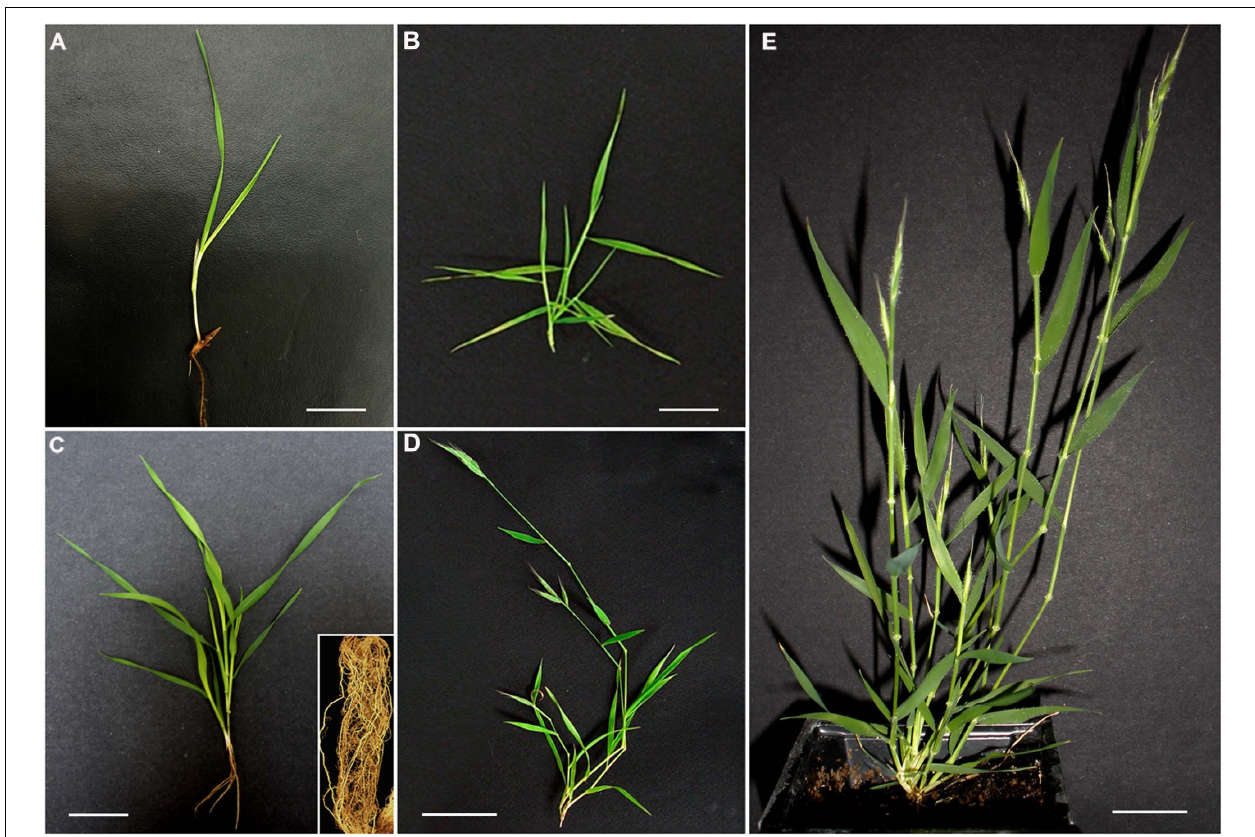
FIGURE 2 | Brachypodium developmental stages. (A) Early vegetative phase (EVP), bar = 1 cm; (B) late vegetative phase (LVP), bar = 2 cm; (C) transition phase (TP), bar = 2 cm; (D) reproductive phase (RP), bar = 3 cm; (E) advanced phase (AP), bar = 2 cm.